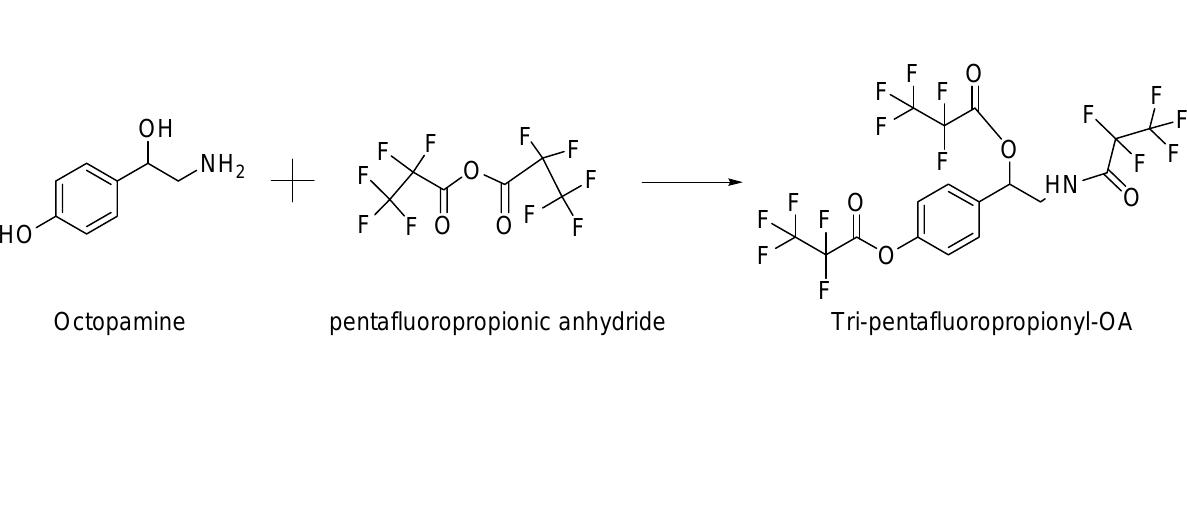
Figure 1. Chemical structure of Octopamine and its possible reaction product with